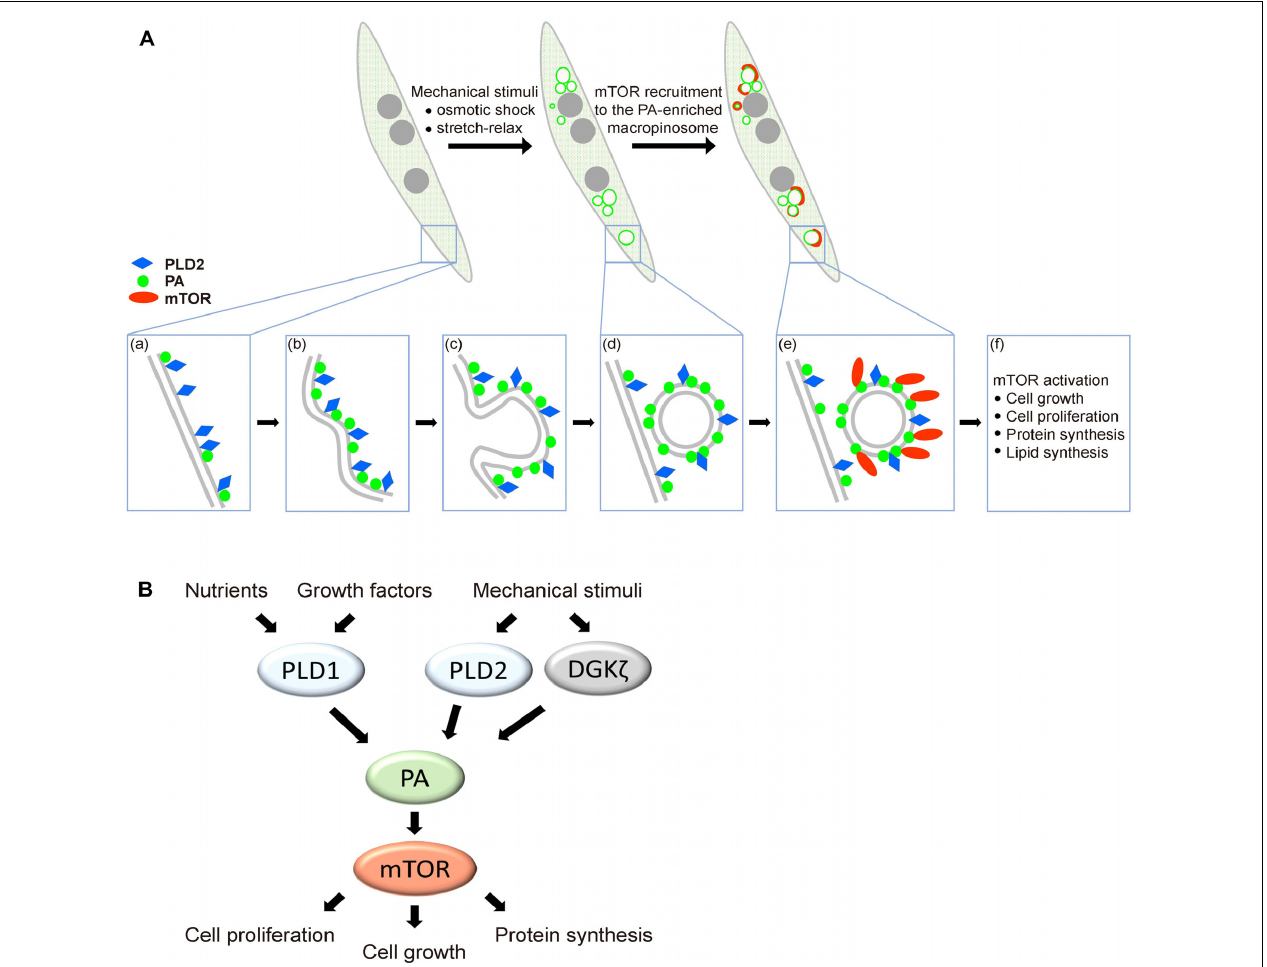
FIGURE 6 | Hypothetical model of mechanical stimulation-induced mTOR distribution and activation in muscle. (A) Mechanical stimulation leads to the formation of PA-enriched macropinosome which serves as a platform for mTOR recruitment. Plasma membrane-localized PLD2 (a) is activated via mechanical stimulation and the production of PA is involved in macropinosome formation (b–d) . mTOR is recruited to the PA-enriched macropinosome and results in mTOR signaling activation (e,f) . (B) Biochemical and mechanical transduction pathway for mTOR activation. Growth factors stimulate the activation of mTOR mainly through the activity of PLD1 on lysosome, whereas mechanical stimulation induces mTOR activation and localization to macropinosome mainly through